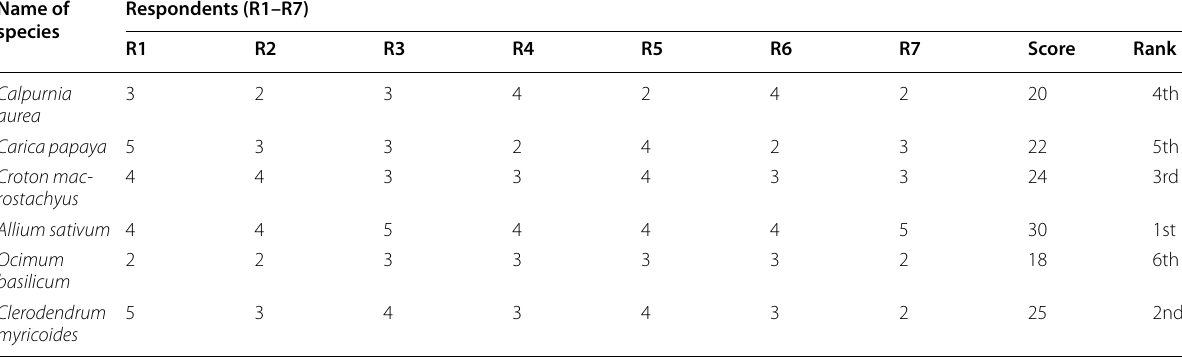
Table 6 Preference ranking of medicinal plants used for treating malaria